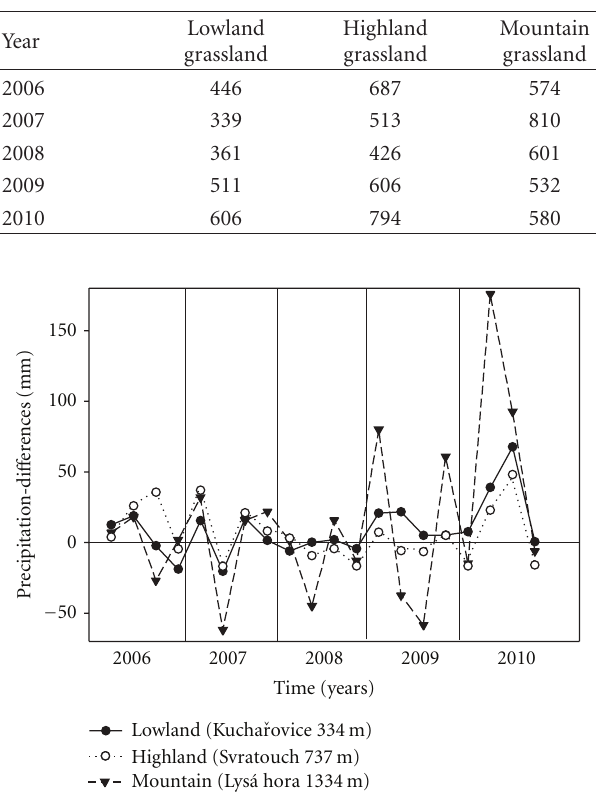
Figure 1: Di ff erences in the amount of precipitation from the long- term average values (1961–1990) recorded at the meteorological stations Kuchaˇrovice (lowland), Svratouch (highland), and Lys´a hora (mountain, approximately 9, 4, and 8km from studied sites, resp.) and calculated for quarters of the years of 2006 to